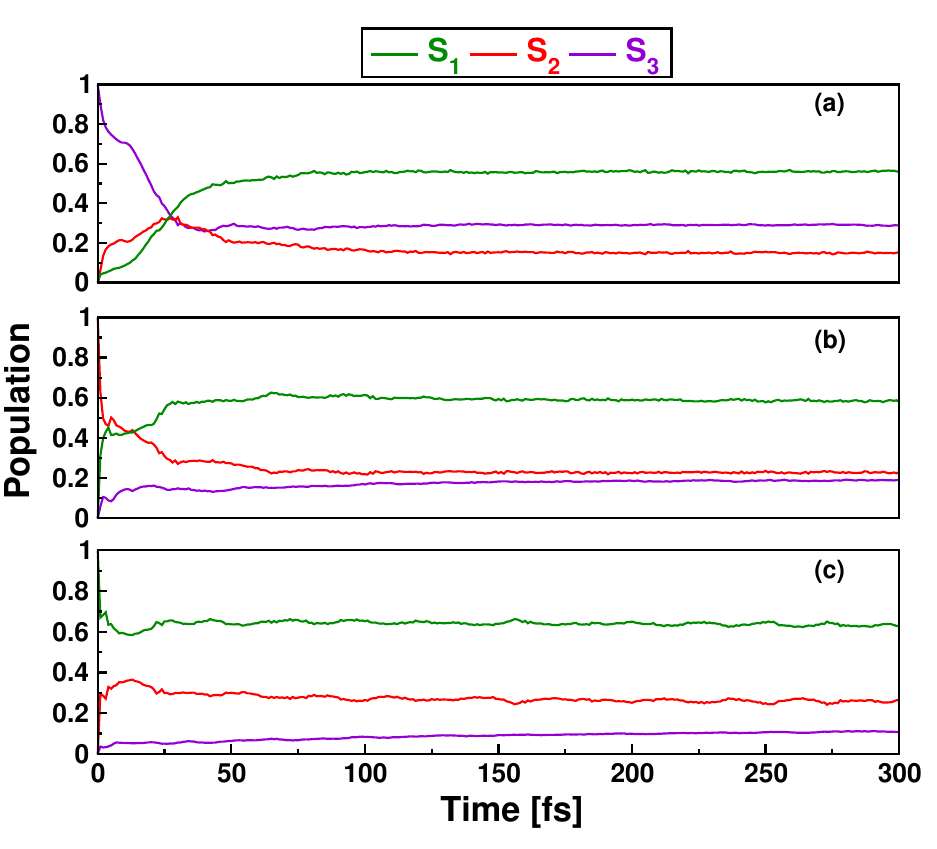
Figure 5. Diabatic electronic population profiles of singlet excited-states generated by propagation of initial wavepacket on ( a ) S 3 , ( b ) S 2 , and ( c ) S 1 of C 7 H 4